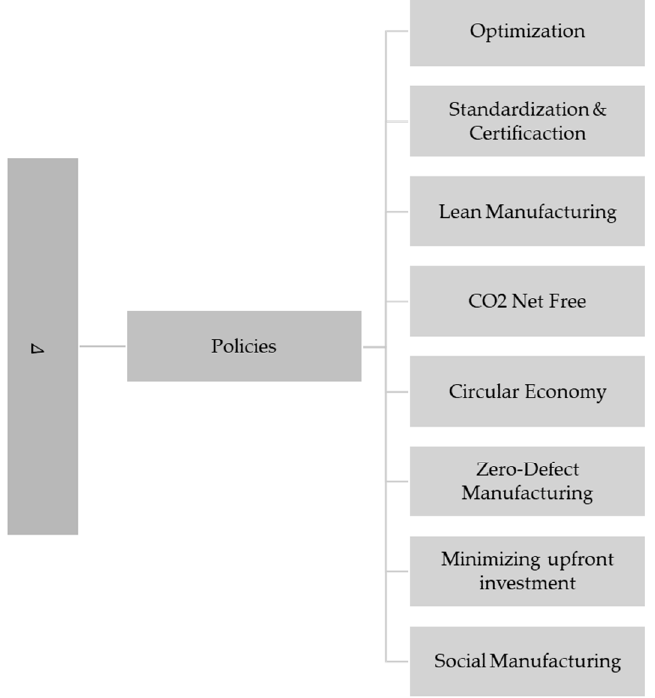
Figure A10. Technologies’ classification: Materials-related branch.